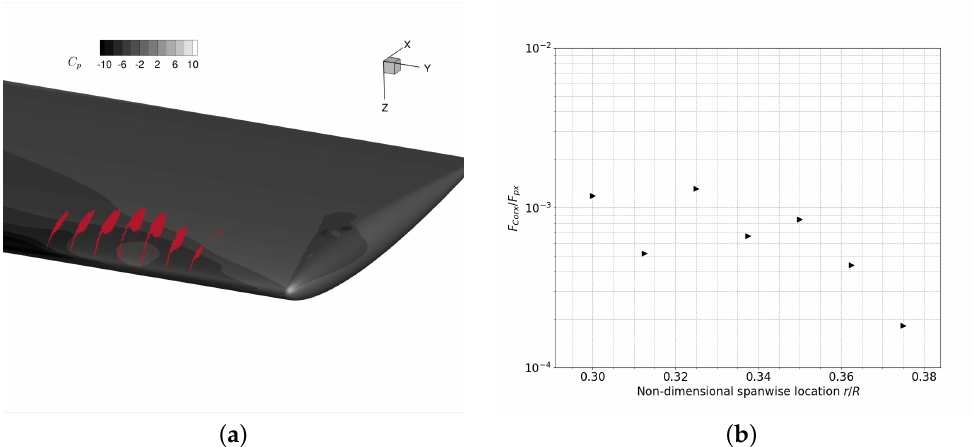
Figure 12. Comparison of the pressure force and the Coriolis force in vortex cores. ( a ) area of integration, where Q > 0; ( b ) ratio of Coriolis force in the x -direction and pressure force in the x -direction ∆ F Cor / ∆ F px